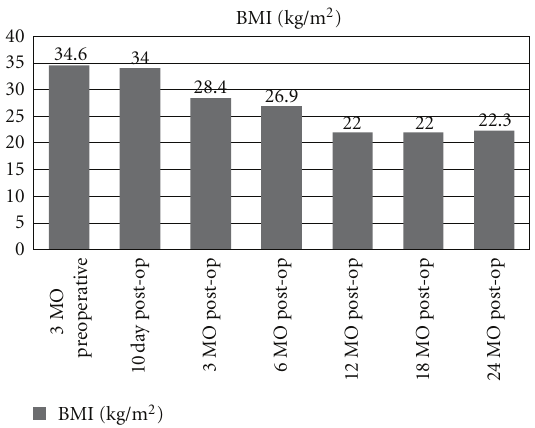
Figure 2: Patient’s BMI 3 months preoperatively through 24 months